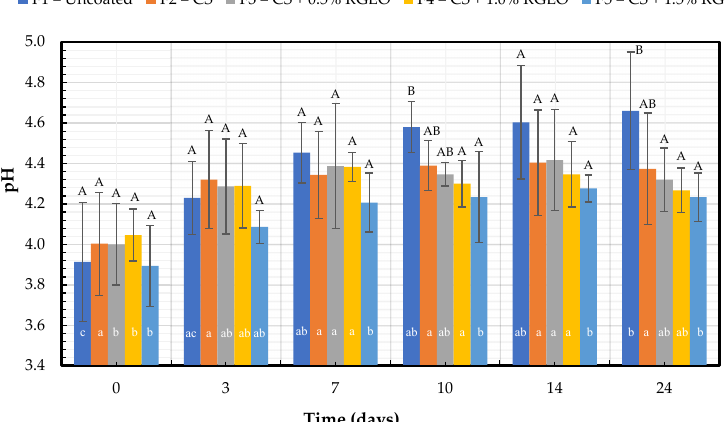
Figure 1. Evolution of pH in pears with CS + RGEO treatments: F1 = uncoated, F2 = CS, F3 = CS + RGEO 0.5%, F4 = CS + RGEO 1.0%, and F5 = CS + RGEO 1.5%. According to the ANOVA test, mean values and intervals of Duncan test for treatments and Fisher for days with 95%. Different lowercase letters (a, b, c) indicate significant differences between days according to the Least Significant Differences (LSD) Fisher test for each treatment in a confidence interval of 95%. In contrast, different uppercase letters (A, B, C) indicate significant differences between treatments for each day according to the Duncan test in a confidence interval of 95%.